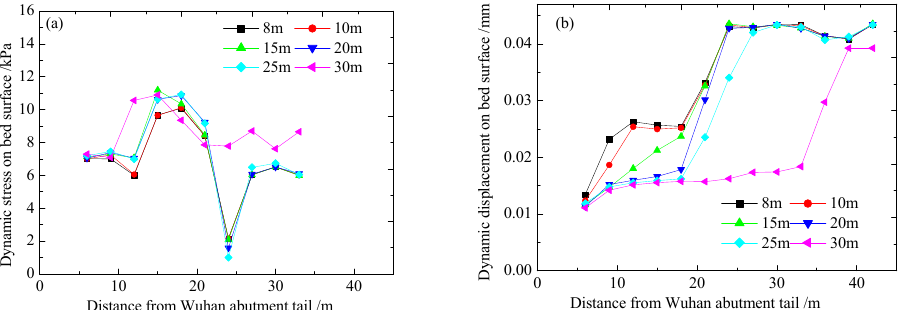
Figure 12. Effect of transition length on dynamic response of surface layer of subgrade bed: ( a ) dynamic stress; ( b ) dynamic displacement.